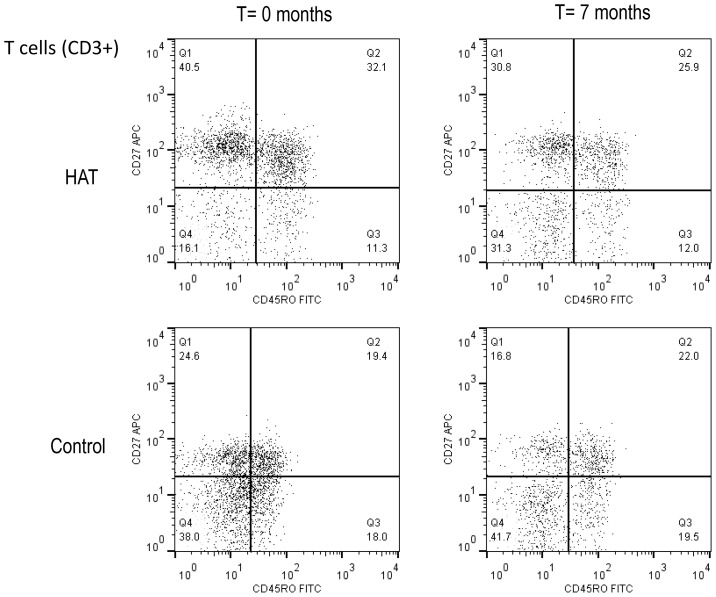
Flow cytometry dot plot of the CD3+ T-cell population in HAT and in a control.T-cell subsets were based on the CD27 and CD45RO cell surface markers. A HAT patient before and after treatment (T = 0 and 7 months), and a control at the same time points are shown. Cut-offs for considering a cell surface marker positive or negative are shown as solid lines, and subdivide the graph into 4 quadrants (Q1–Q4). T-cell subsets in each quadrant are expressed as percentages of CD3+ T cells.